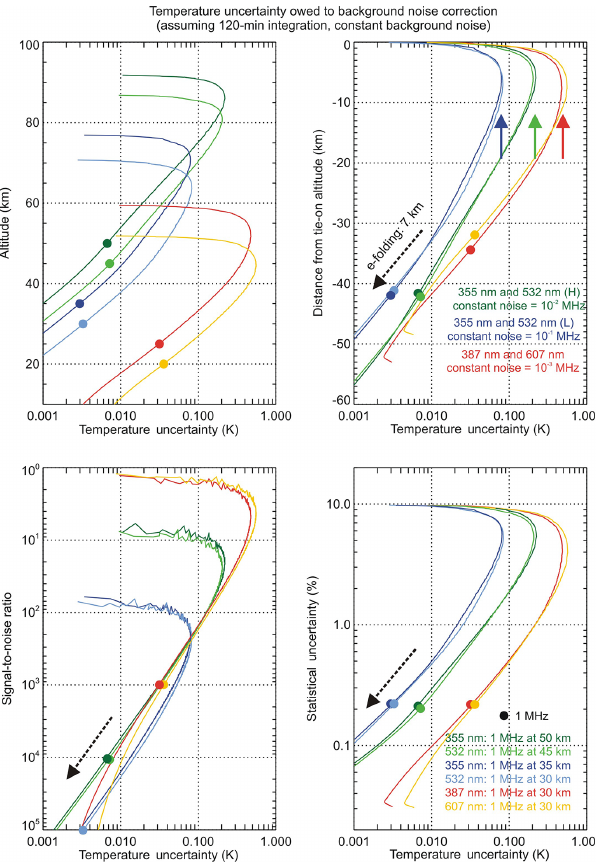
Figure 3. Temperature uncertainty owing to background noise cor- rection as a function of altitude (top-left), distance from tie-on (top- right), signal-to-noise ratio (bottom left), and statistical uncertainty (bottom-right), for a variety of signal and noise strengths (see Fig. 1 caption for